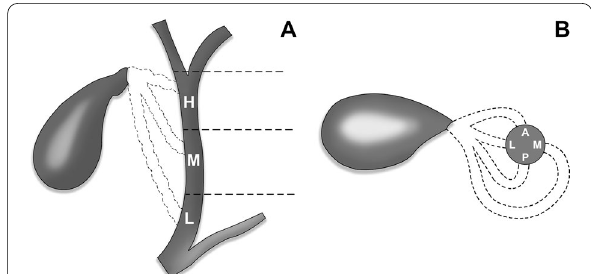
Fig. 1 Schematic demonstration of cystic duct confluence with extrahepatic bile duct. The craniocaudal insertion level is labeled by the letters H, M and L indicating high, mid and low insertions, respectively ( a ). The transverse site of insertion is labeled by the letters L, A, M and P indicating lateral, anterior, medial and posterior insertions, respectively ( b )